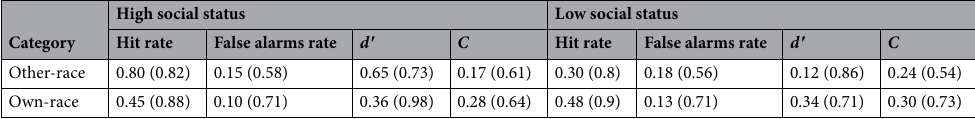
Table 1. Average hit rate, misrepresentation rate, d ′ , and C in Study 1. The numbers outside the brackets in the table are the means, and the numbers inside the brackets are the standard